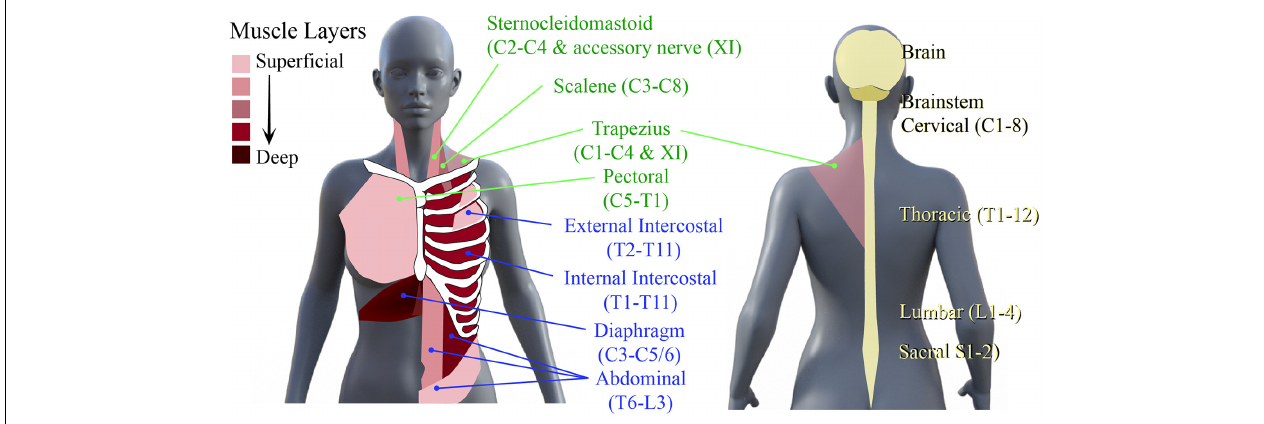
FIGURE 1 | Primary muscles of respiration and their neural circuitry. Schematic diagram of human torso showing the location of the primary muscles of inspiration and expiration and the spinal levels that innervate